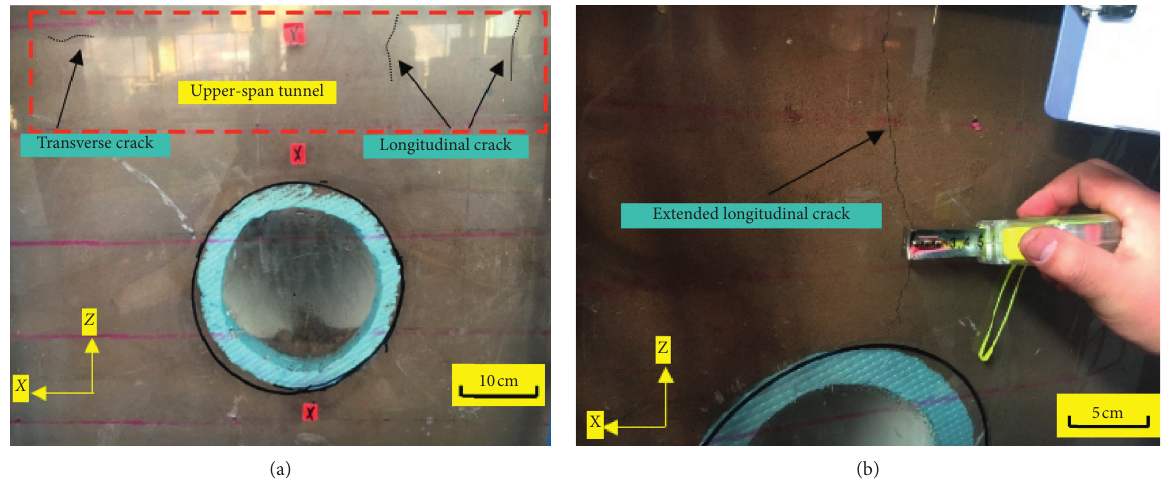
Figure 9: Model deformation and failure: (a) main view; (b) rear view.